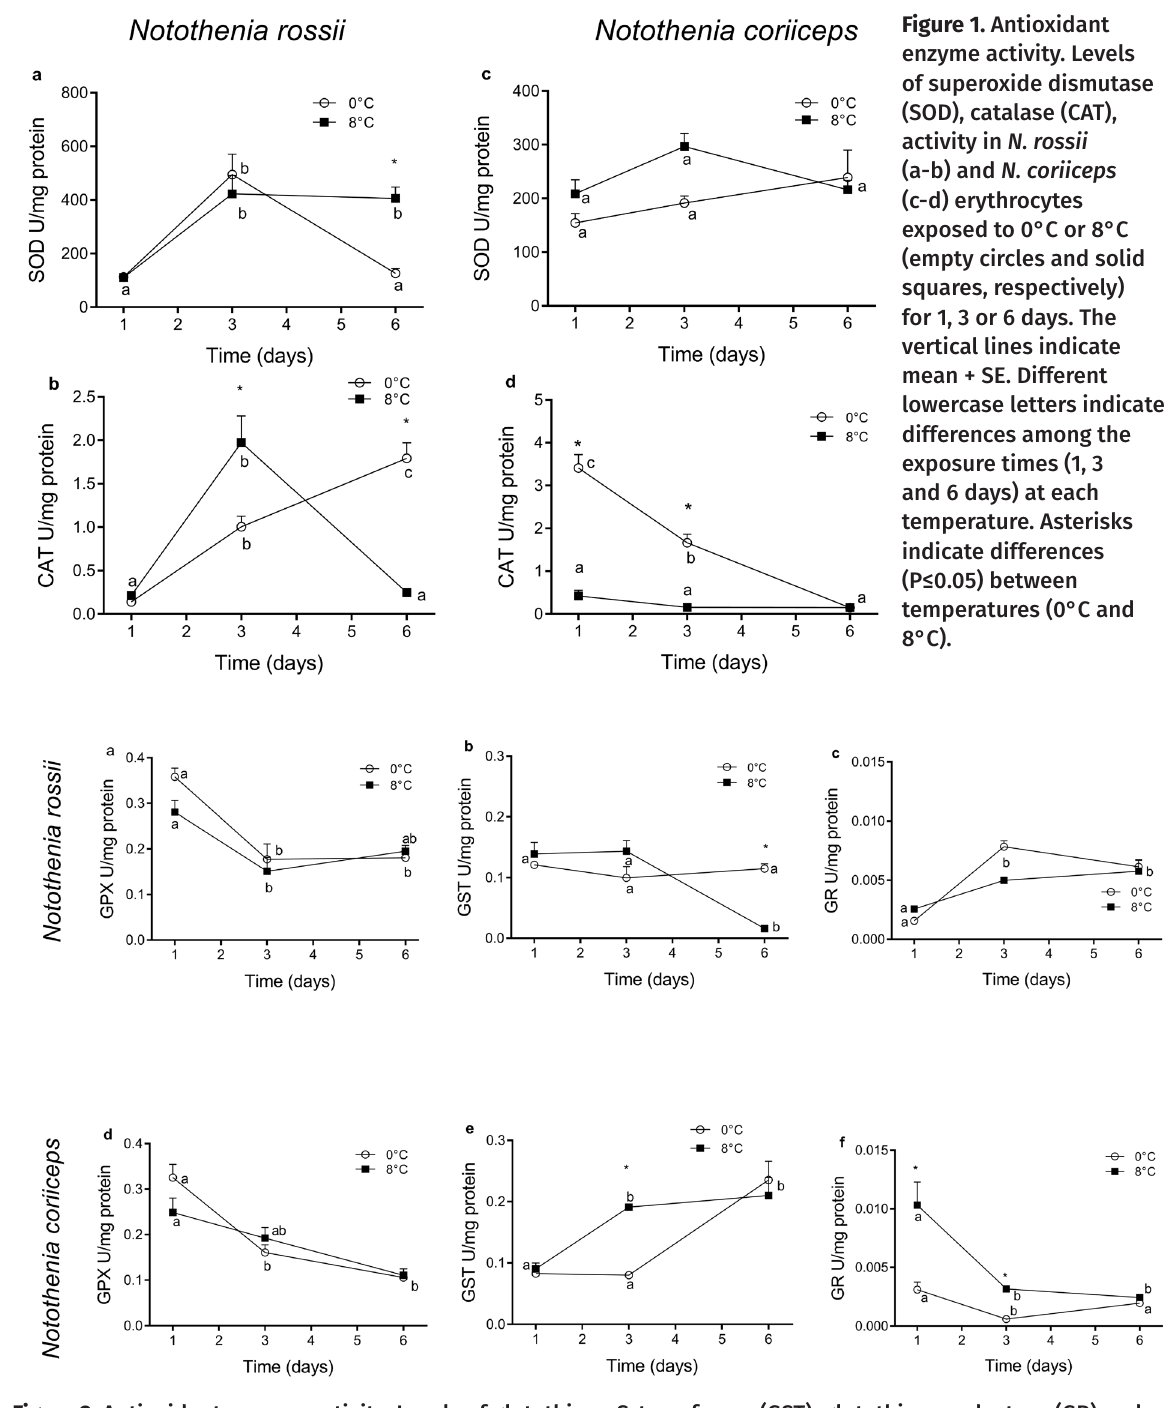
Figure 2. Antioxidant enzyme activity. Levels of glutathione S-transferase (GST), glutathione reductase (GR) and glutathione peroxidase (GPx) activity in N. rossii (a-b-c) and N. coriiceps (d-e-f) erythrocytes exposed to 0°C or 8°C (empty circles and solid squares, respectively) for 1, 3 or 6 days. The vertical lines indicate mean + SE. Different lowercase letters indicate differences among the exposure times (1, 3 and 6 days) at each temperature. Asterisks indicate differences (P≤0.05) between temperatures (0°C and